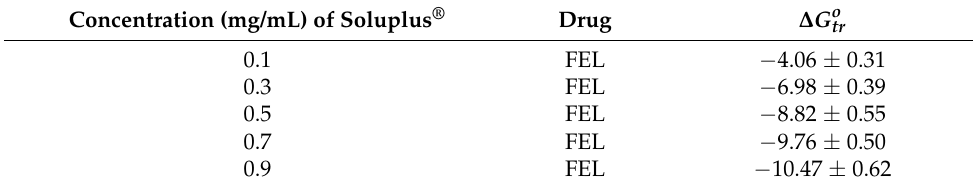
Table 3. The Gibbs free energy of transfer ( ∆ G o ) of FEL in PBS (pH 6.8) with pre-dissolved Soluplus ® tr concentrations ranging from 0.1 to 0.9 mg/mL. Standard deviation expressed by error bars ( n = 3). Concentration (mg/mL) of Soluplus ® Drug ∆ G o tr 0.1 FEL